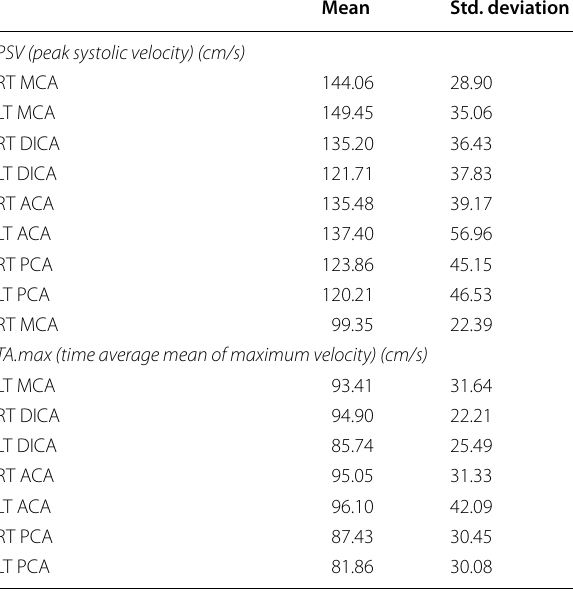
TCD transcranial Doppler, Rt right, Lt Left, MCA middle cerebral artery, DICA distal internal carotid artery, ACA anterior cerebral artery, PCA posterior cerebral artery